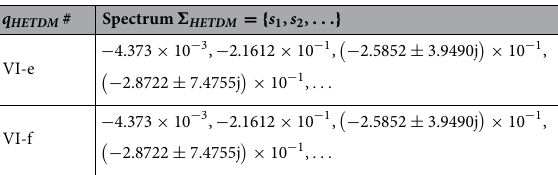
Table 6. Dominant pole HETDM spectra.